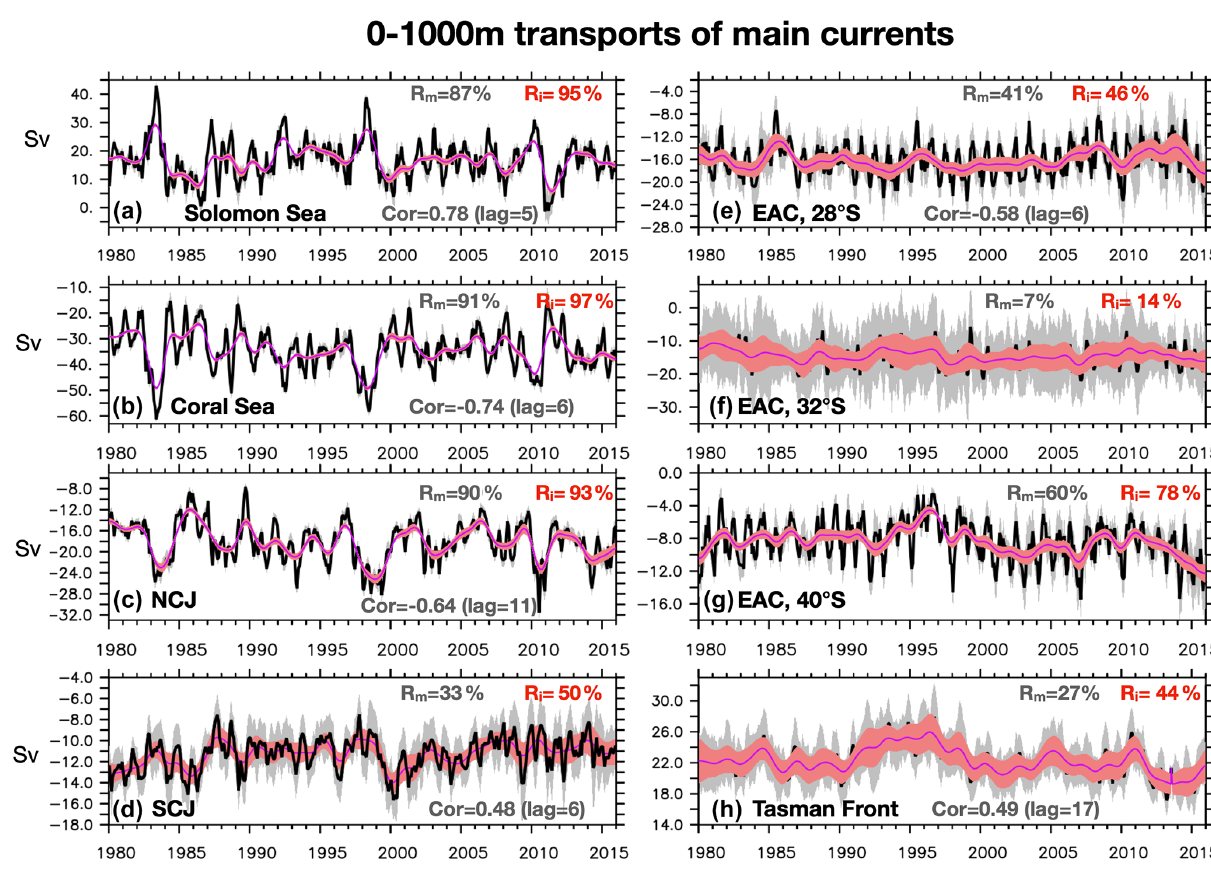
Figure 4. Time series of the 0–1000m integrated transports across various sections (in Sv). In black: monthly values from the ensemble mean; in grey shades is the ensemble mean plus or minus the monthly ensemble spread. In red: interannual values from the ensemble mean, and the red shades represent the ensemble mean plus or minus the interannual ensemble spread. The percentage of the deterministic variance is given as R m for the monthly values and R i for the interannual values. The maximum correlation of the transport with the Nino3.4 index is also given, with the associated lag in months. (a) Meridional transport through the entrance of the Solomon Sea (positive is northward). (b) Zonal transport through the entrance of the Coral Sea (positive is eastward). (c) Westward transport of the NCJ. (d) Westward transport of the SCJ. (e) Meridional total transport of the EAC at 28 ◦ S (see Sect. 2.3 for definition). R m and R i for the southward-only meridional transport are 44% and 58%, respectively. R m and R i for the northward recirculation branch are 21% and 50%, respectively. (f) Meridional total transport of the EAC at 32 ◦ S. R m and R i for the southward-only meridional transport are 10% and 29%, respectively. R m and R i for the northward recirculation branch are 6% and 22%, respectively. (g) Meridional transport of the EAC at 40 ◦ S. (h) Zonal transport of the Tasman Front. See text for